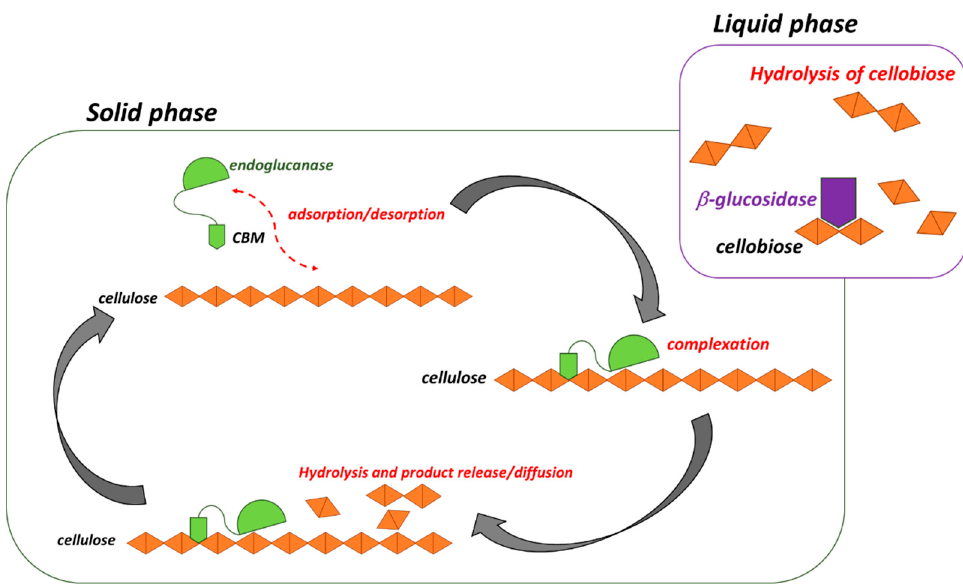
Figure 2. Illustration of the main steps of the cyclic mechanism of interaction between the hydrolytic enzyme molecule and cellulose chain [13]. CBM—Cellulose Binding